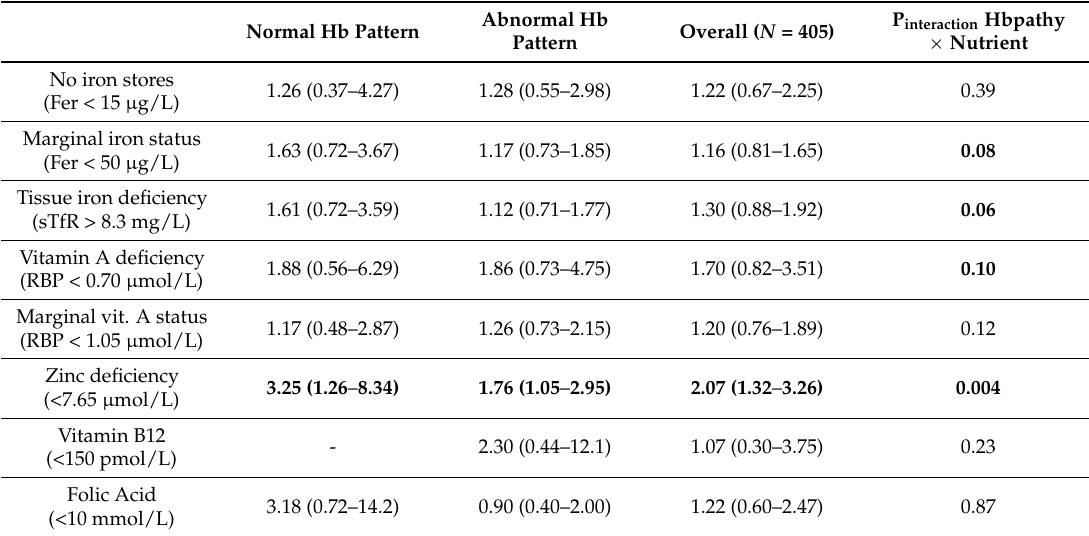
Table 4. Unadjusted univariate odds ratios of iron and other vitamin and mineral deficiencies to anemia in children ( N = 400) 1 .